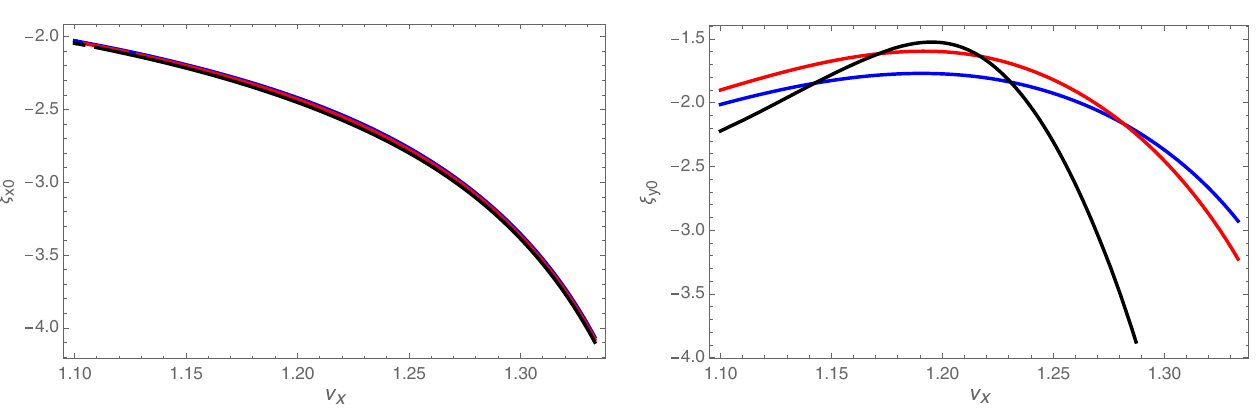
FIG. 7. The natural chromaticity in the horizontal (left) and vertical (right) planes as a function of the betatron tunes with various ∶ ν 1 ∶ 5 , 1:4, and 1 ∶ 3 represented by blue, red, and black, respectively. ratios: ν y x ¼